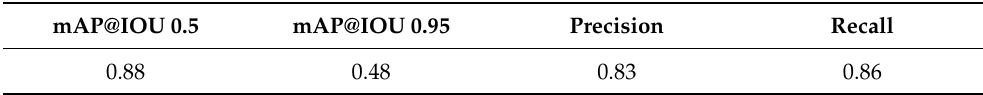
Table 1. Validation metrics for